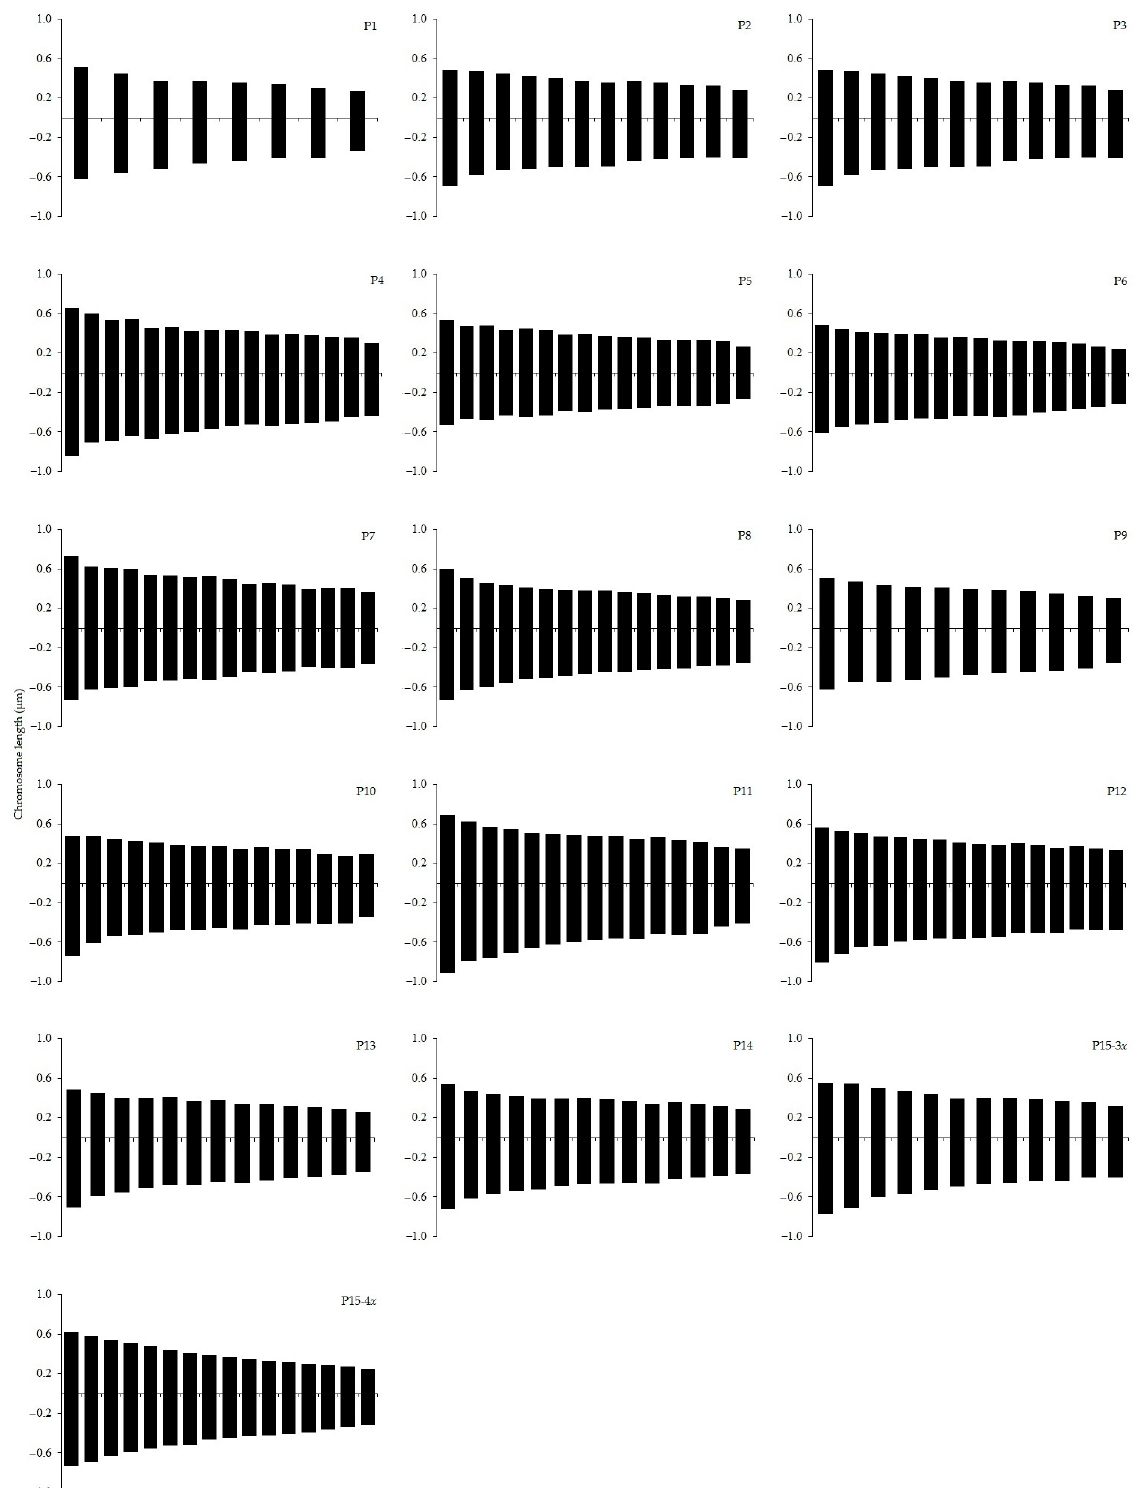
Figure 2. Haploid chromosome idiograms of 15 Hypericum perforatum populations .